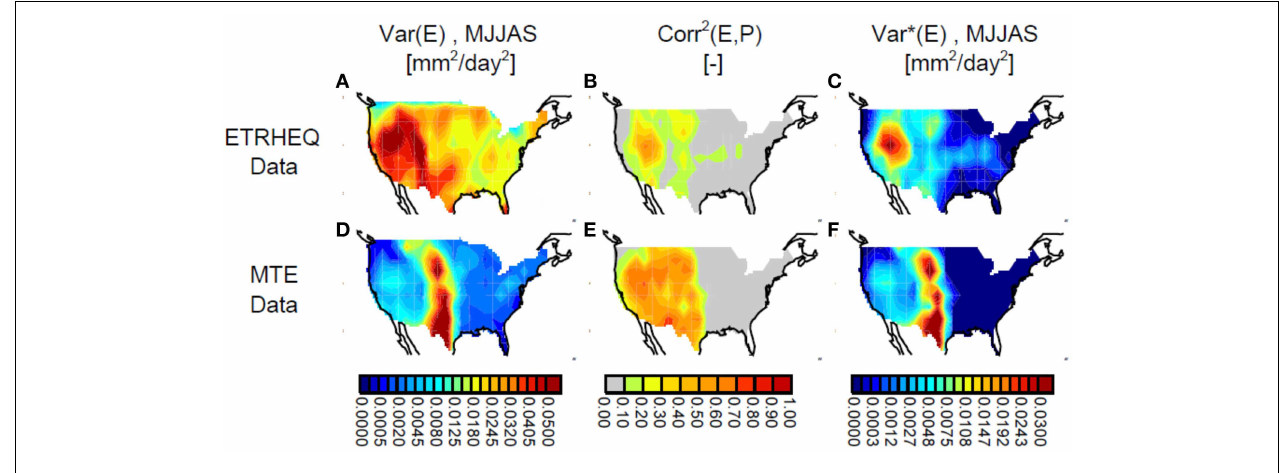
FIGURE 1 | (A) Variance of MJJAS evapotranspiration, σ 2 E , as determined from the evapotranspiration dataset of Rigden and Salvucci (2015) . (B) Square of the correlation coefficient, Corr 2 (E,P), between MJJAS evapotranspiration from the dataset of Rigden and